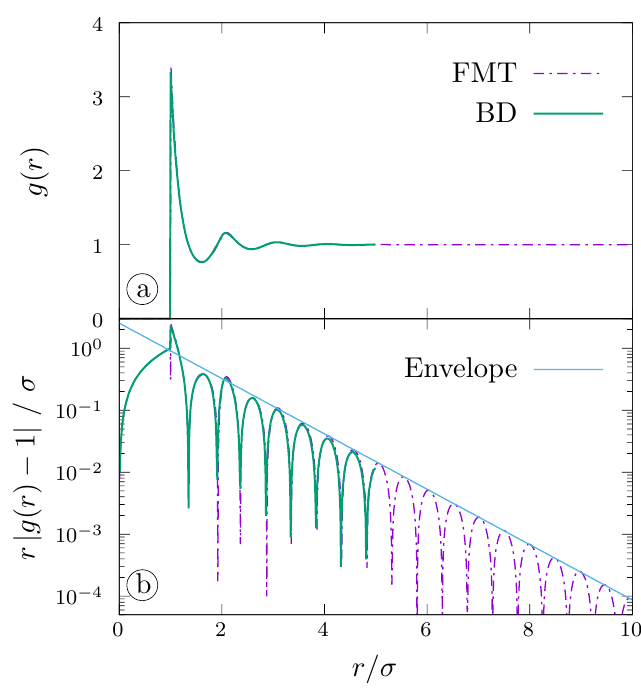
Figure 1: The radial distribution function g ( r ) of a hard sphere liquid as a function of the distance r /σ at packing fraction η ≈ 0.38. Results from FMT (dash-dotted purple line) are compared to BD simulation (full green line). Panel (a) shows the radial dis- tribution function on a linear scale. Panel (b) shows the deviation ln ( r | g ( r ) − 1 | /σ ) from the bulk value on a logarithmic scale. Here, many correlation shells can be